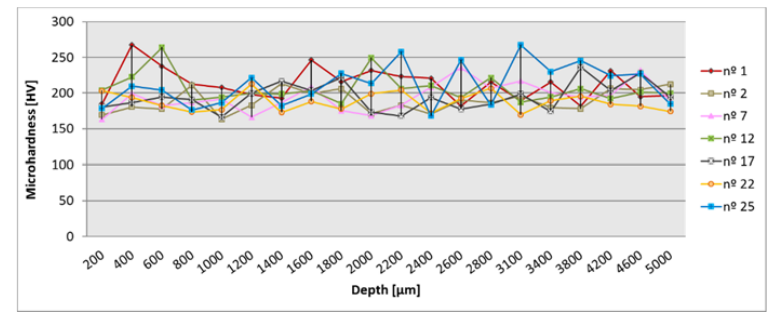
Figure 15. Microhardness measured in tooth n o (number) 1, 2, 7, 12, 17, 22, and 25.